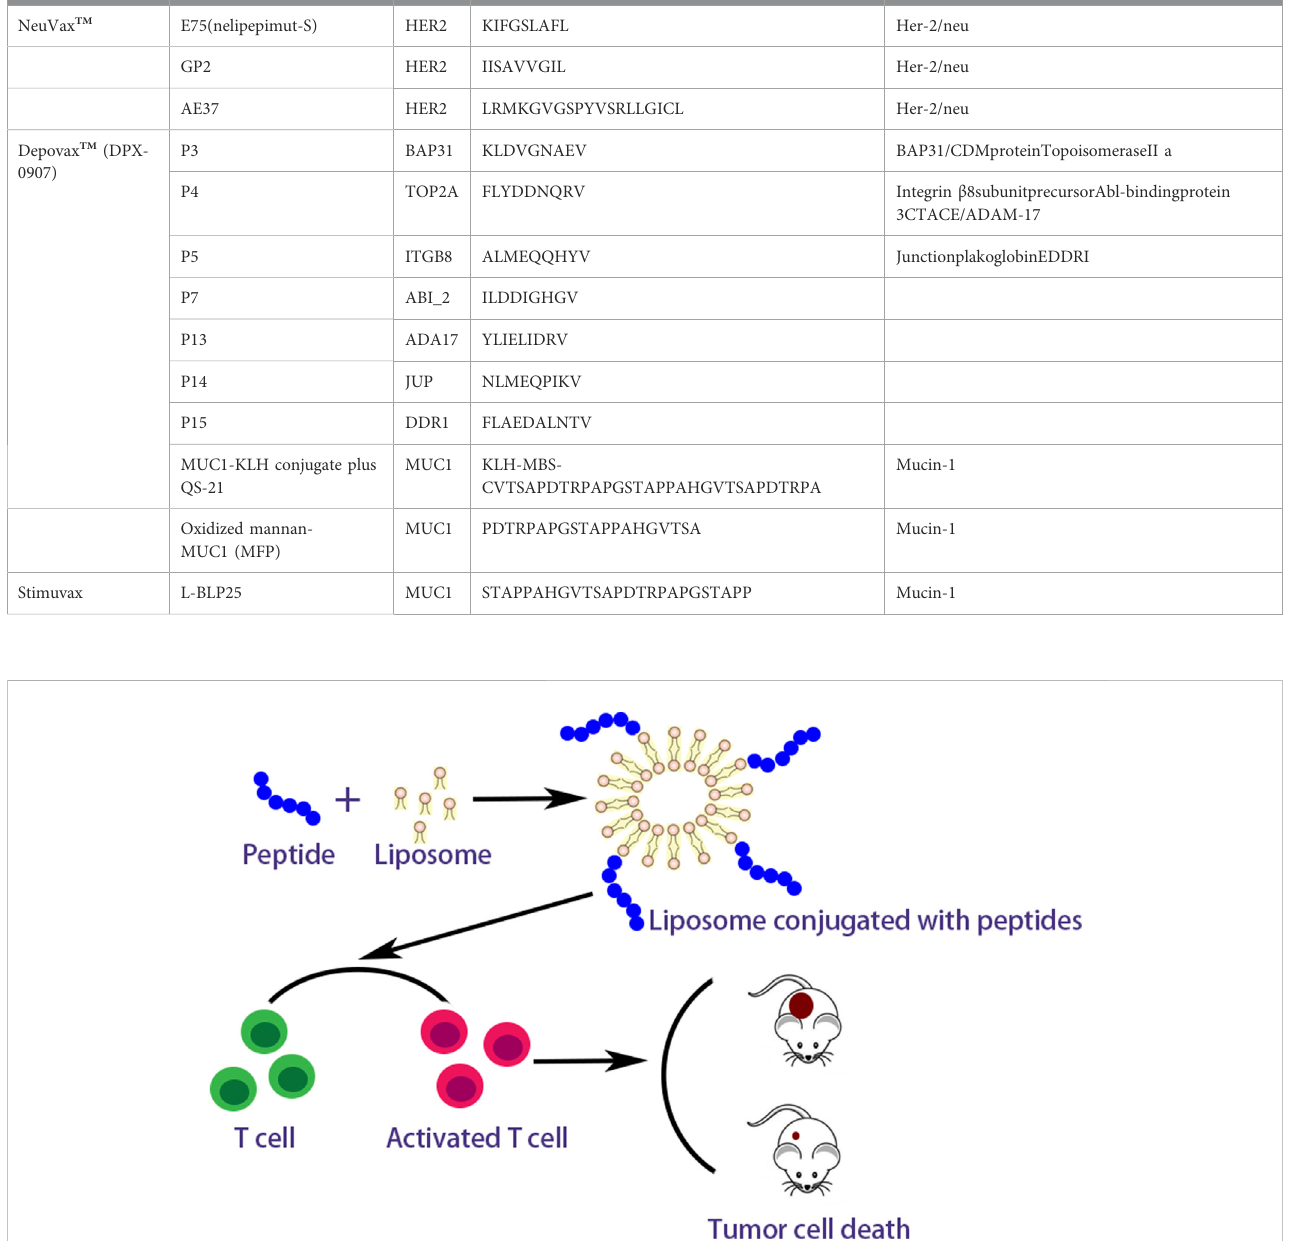
TABLE 3 Summary of the vaccination based on peptide clinical trials on breast cancer patients. (de Paula Peres et al., 2015). Vaccine Peptide Gene